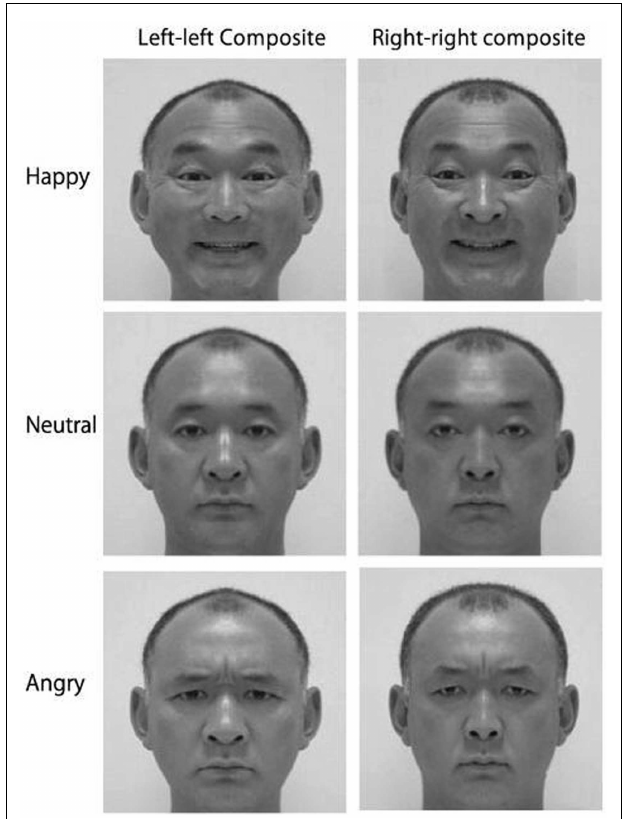
FIGURE 1 | Examples of mirrored chimeric face stimuli; people tend to select the left–left chimeras as showing stronger emotion than the right–right chimeras (Reprinted from Okubo et al., 2013, Copyright with permission from Elsevier) .